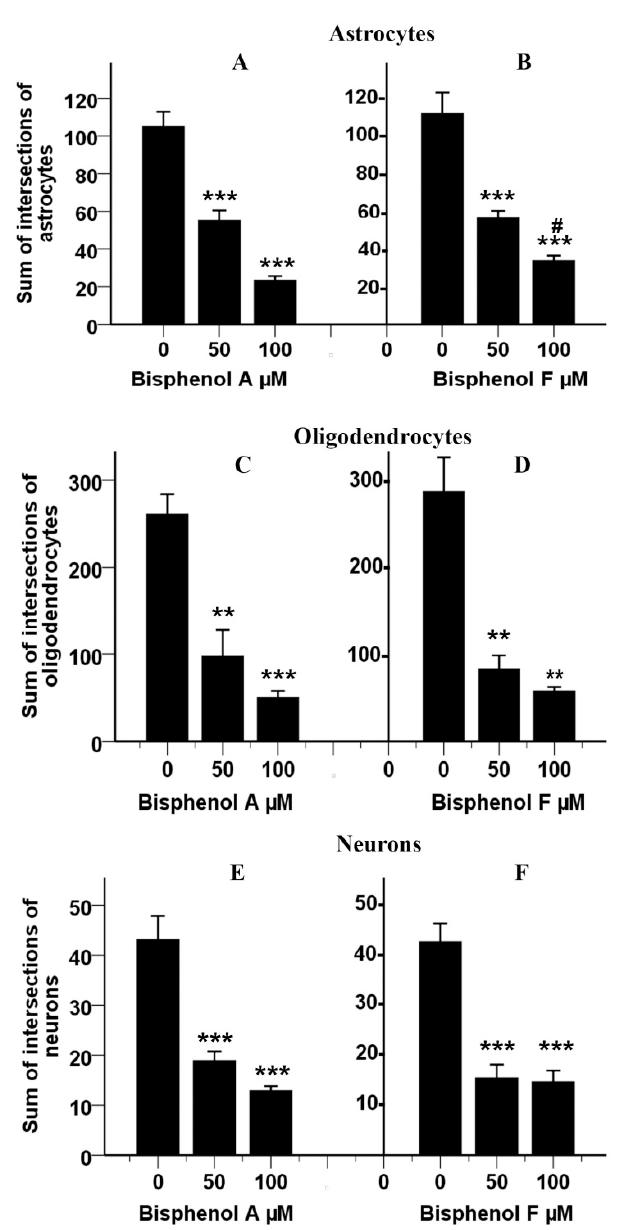
Figure 10. Effects of different concentrations of BPA or BPF treated for seven days on morphometric analysis of astrocytes, oligodendrocytes, and neurons differentiated from rNSCs in relevant cell-specific directed differentiation medium. The sum of intersections of cellular processes per cell was used as an index of morphological changes of astrocytes ( A , B ), oligodendrocytes ( C , D ), and neurons ( E , F ). Differentiated astrocytes ( n = 15–19 per group), oligodendrocytes ( n = 11–18 per group), and neurons ( n = 18–29 per group) were visualized with specific protein-marker GFAP, mGalc, and MAP2, respectively, and nuclei stained with DAPI. Fluorescent signals were segmented and transformed to binary mask for tracing complete cell morphology. Traced cell images were subjected to Sholl analysis to enumerate the sum of intersections per cell. Each data points represents mean ± SE; ** p < 0.01, *** p < 0.001 compared with the relevant control groups. # p < 0.05 compared with 100 µM BPA treated group.